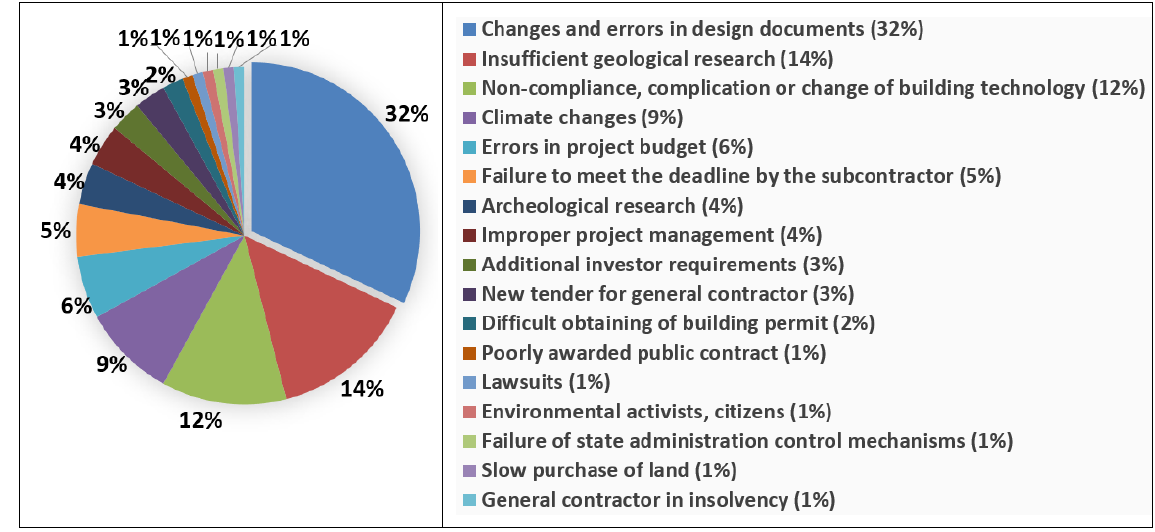
Figure 2: Main reasons for the failure to meet the budget for 190 projects (Source: